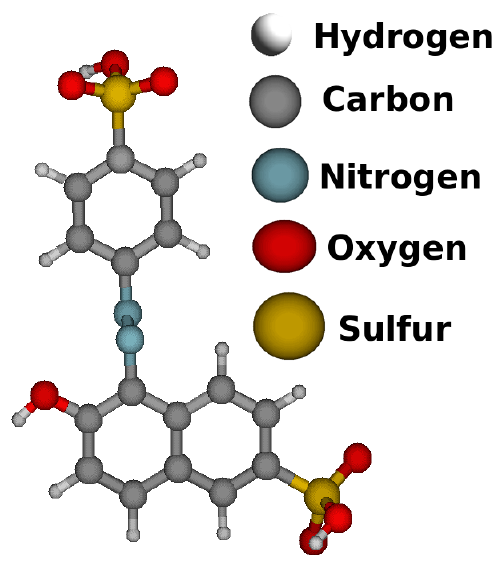
Figure 1. Ball and stick atomic model of Sunset Yellow.